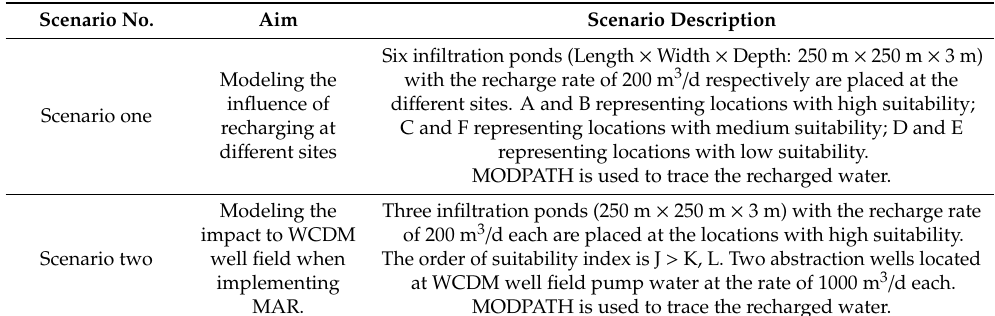
Figure 10. Recharge sites of the MAR in the modeling shown on the suitable sites map. Table 3. Details of the modeling scenarios.